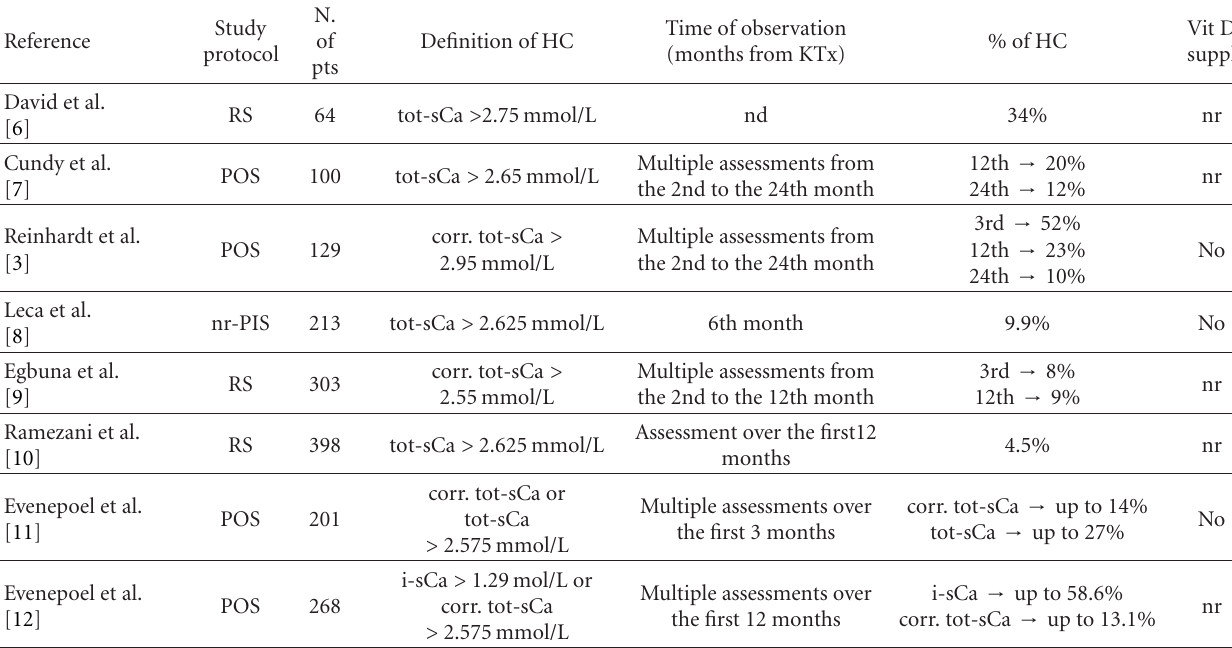
Table 1: Prevalence of Hypercalcemia (HC) after Kidney Transplantation (KTx) in di ff erent